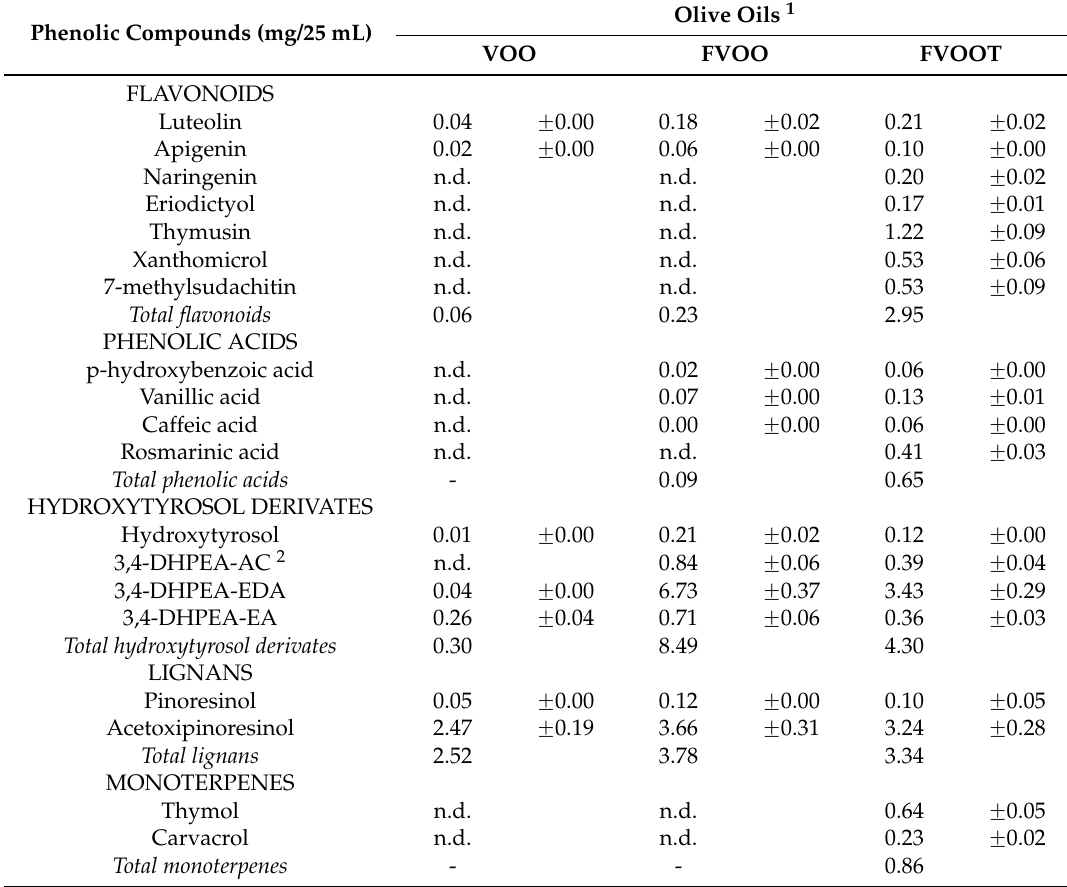
Table 1. Phenolic composition of the olive oils used in the